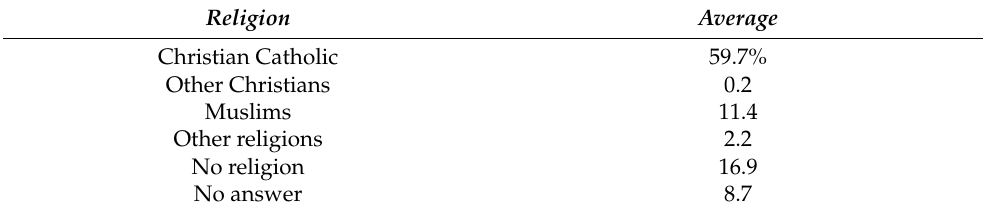
Table 1. Religious affiliations.